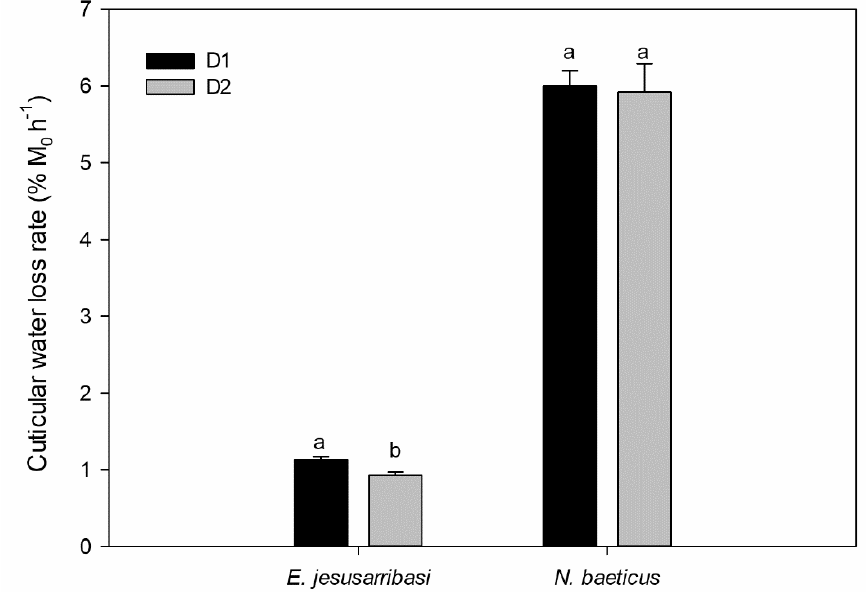
Figure 2. Cuticular water loss rate measured in D1 (individuals from the control exposed to desiccation) and D2 (individuals from the prior desiccation exposed to a subsequent desiccation). Lowercase letters indicate significant differences between treatments in Bonferroni post hoc tests ( p < 0.05).